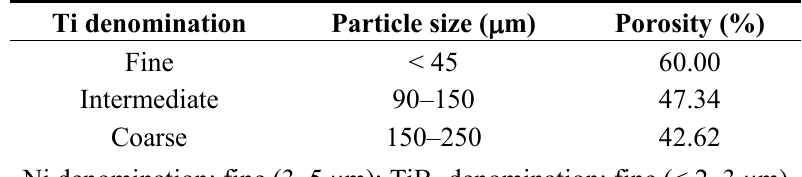
Table 3. Porosity of combustion synthesized samples using different size Ti